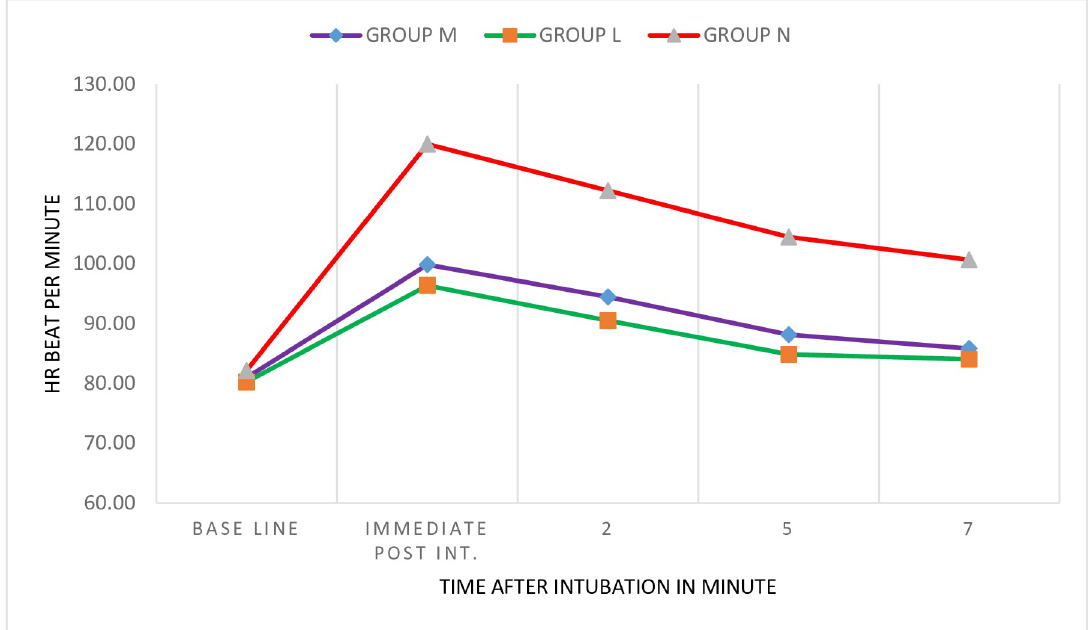
Fig 1. Within-the group change in heart rate at different time intervals in Zewditu Memorial Hospital, Addis Ababa, 2018/2019.